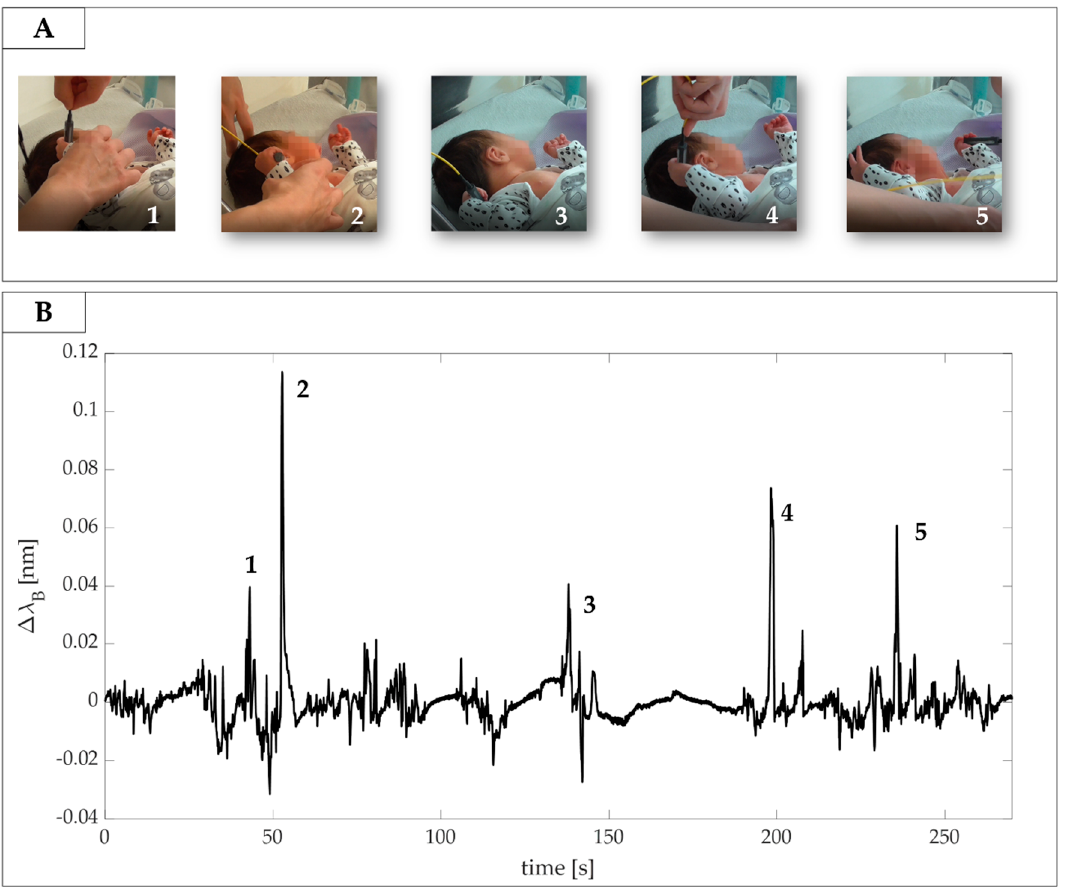
Figure 8. ( A ) Video frames of grasping actions identified by the clinicians; ( B ) the related signals collected by the SGD. Grasps actions are enumerated from 1 to